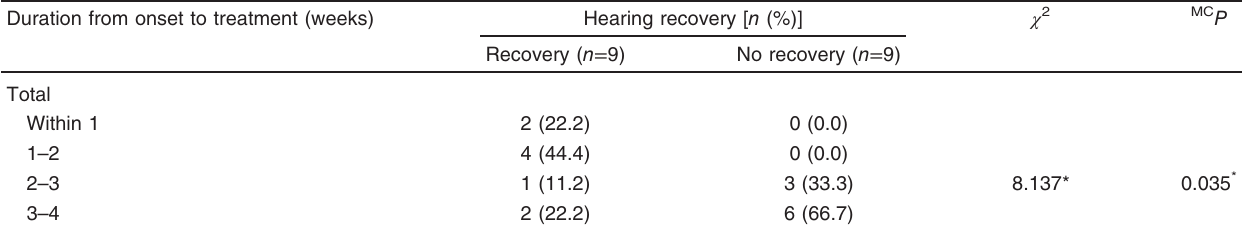
Table 2 Relation between hearing recovery and duration of the disease from its onset to start of treatment (weeks) ( N = 18)